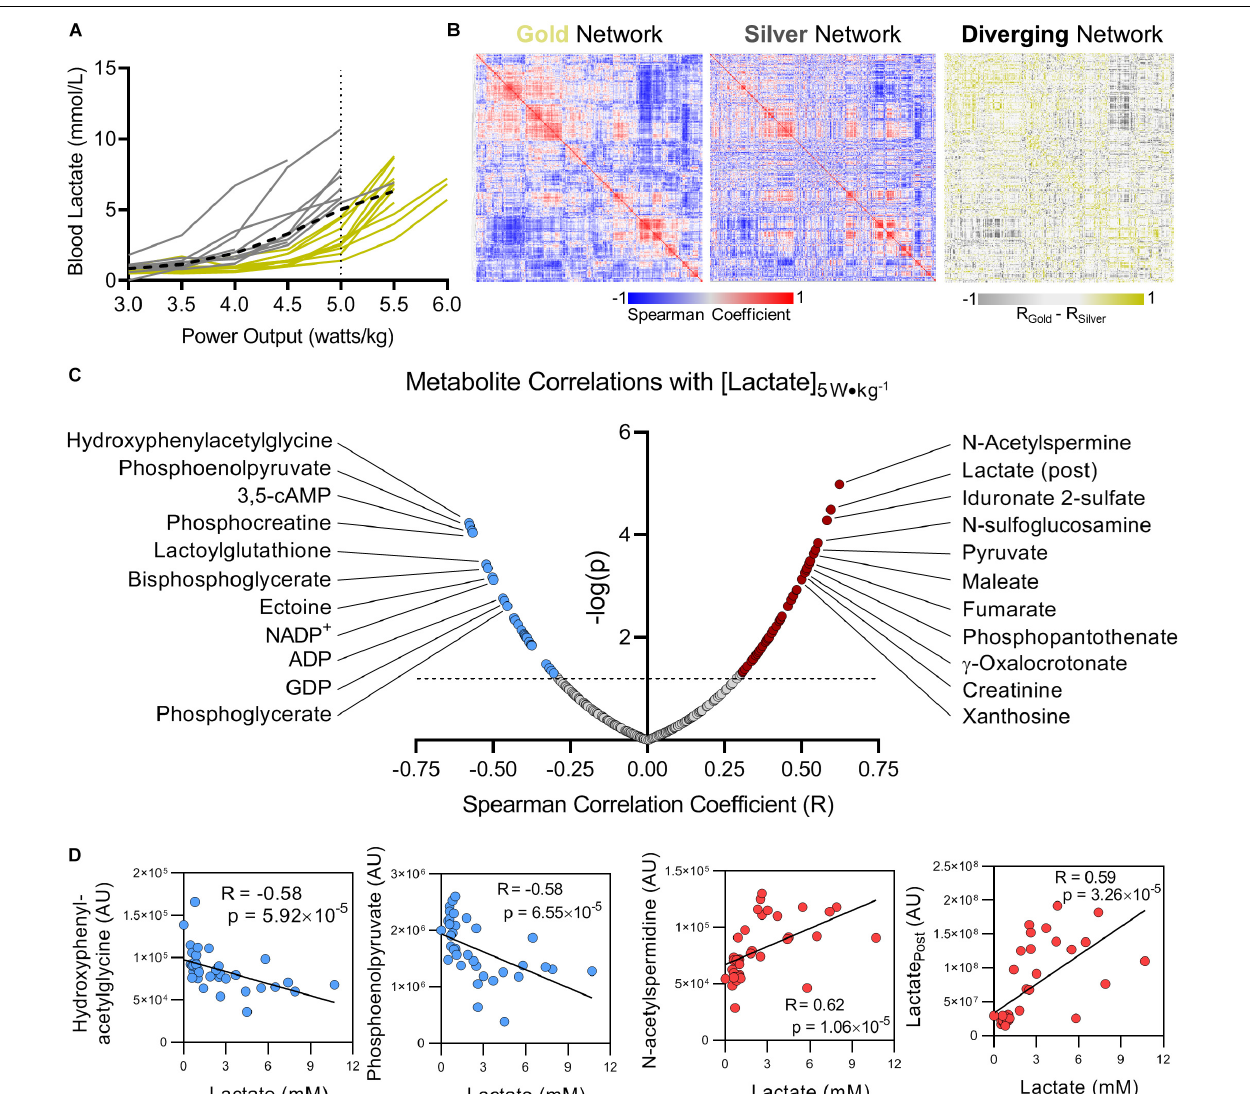
FIGURE 2 | Blood lactate levels as a function of power output can metabolically distinguish cyclists. (A) Using blood lactate levels (in mM) at a power output of 5 W kg − 1 (the maximum output of which most riders achieved, referred to as the performance cutoff, or PC), cyclists were assigned to the Gold or Silver performance groups for having blood lactate levels below or above the group average, respectively (group average indicated with a black dashed line). (B) A Spearman Rank Correlation matrix of metabolites measured in the Gold group was Hierarchically clustered and plotted as a heat map (left) . A Spearman Rank Correlation matrix of metabolites measured in the Silver group was then plotted according to the same hierarchical order determined for the Gold group (center) . The difference of Spearman correlation coefficients between the Gold and Silver group (Gold minus Silver) was then plotted as a heat map according to the same hierarchical order determined for the Gold group. Positive Spearman differences are colored gold, and negative Spearman differences are colored silver. (C) The top significant positive (red) and negative (blue) metabolite correlates with blood lactate concentration measured at 5 W kg − 1 are shown, with the Spearman Correlation Coefficient ( R ) on the x -axis, and -log( p ) on the y -axis. (D) Individual plots are shown for the top 2 metabolites with negative (blue, Hydroxyphenylacetylglycine and Phosphoenolpyruvate) and positive (red, N-acetylspermidine and Lactate post) Spearman correlations with blood lactate concentration measured at 5 W kg − 1 . Associated Spearman Correlation Coefficients and p -values are provided for each. Statistically significant correlations with log( p ) > 1.3 ( p < 0.05) are indicated above the dashed